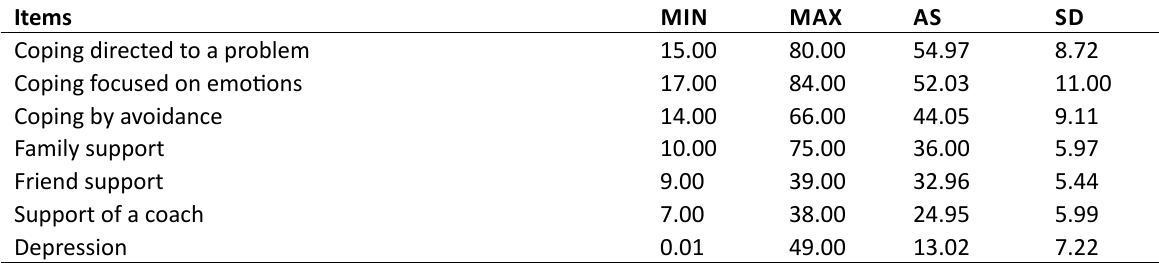
Table 2a. Pearson’s correlation coefficients between examined variables Items